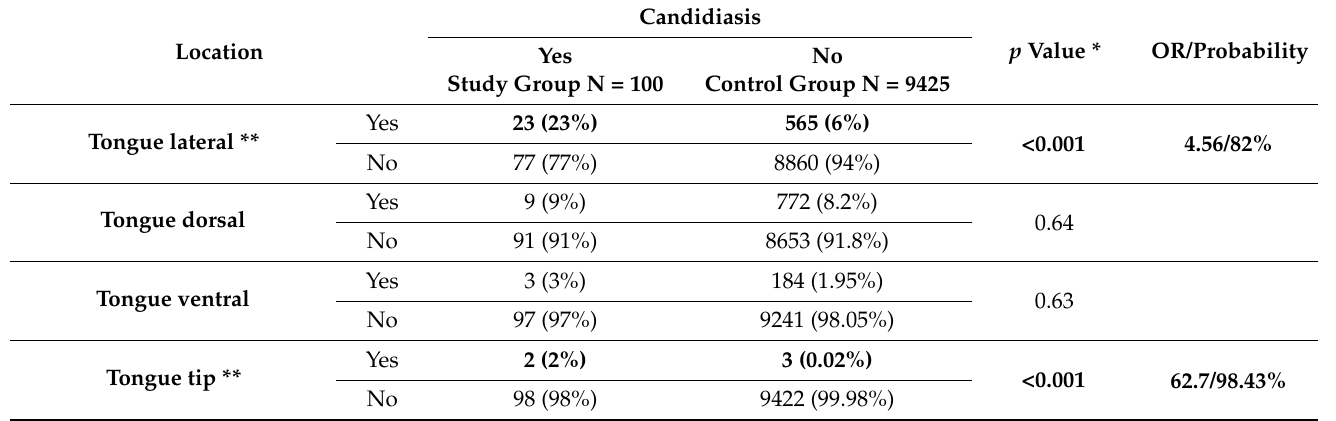
Table 2. Comparison of lesion locations between the study group and the control group (Fisher’s exact